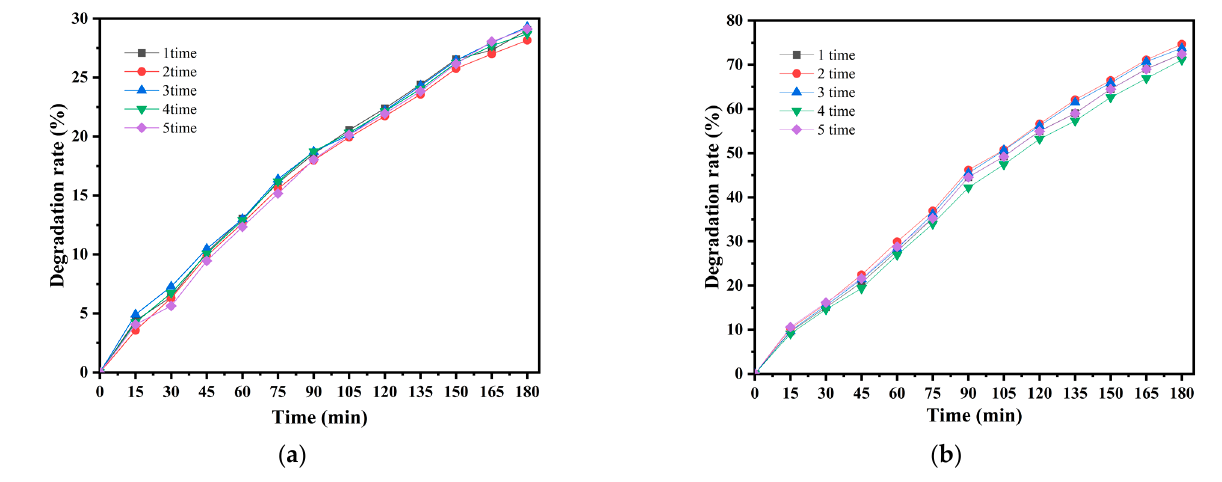
Figure 8. Durability test of the VPFWC-16.62 for photocatalytic degradation of gaseous toluene under visible/ultraviolet light: ( a ) photocatalytic removal performance of the VPFWC-16.62 for gas-phase toluene in 5 visible light cycles; ( b ) photocatalytic removal performance of the VPFWC-16.62 for gas-phase toluene in 5 ultraviolet light cycles.